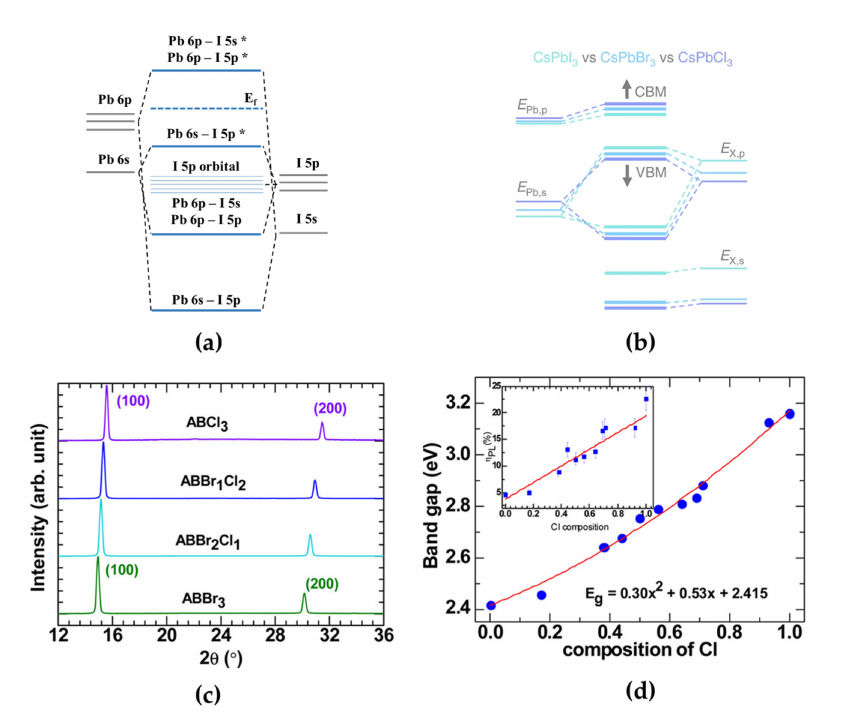
Figure 1. ( a ) Electronic band structures of [PbI 6 ] − 4 (* antibonding orbitals). ( b ) Schematic energy levels in CsPbX 3 perovskites with different halide anions, calculated using tight-binding analysis. Reprinted with permission from [27], Copyright 2019 Springer Nature. ( c ) X-ray diffraction (XRD) patterns of AB(Br 1 − x Cl x ) 3 films (x = 0, 0.33, 0.66, and 1). Reprinted with permission from [39], Copyright 2016 American Chemical Society. ( d ) Quadratic behavior of AB(Br 1 − x Cl x ) 3 bandgaps as a function of Cl content. Reprinted with permission from [37], Copyright 2015 American Chemical